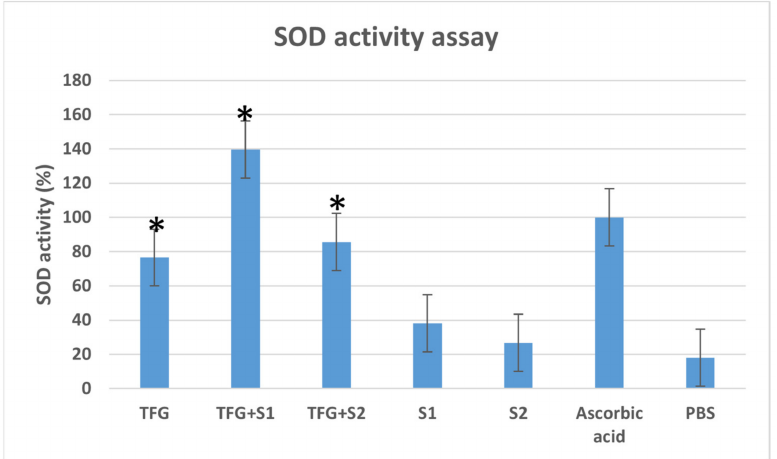
Figure 4. SOD enzyme activity in Caco-2 cells, expressed as the percentage of SOD activity in positive control cells, treated with ascorbic acid solution. Cells treated with PBS were used as the negative control. Data are expressed as the mean ± S.D. and n = 8, with * p < 0.05 compared with